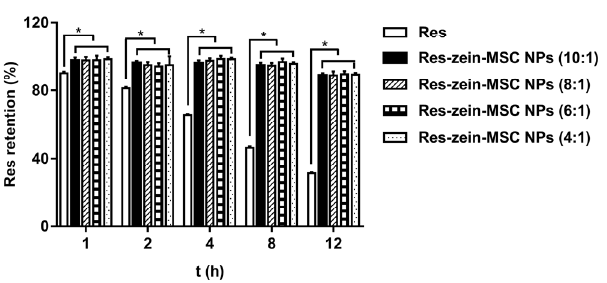
Figure 2. The photo-stability of Res and Res-zein-MSC NPs under UV radiation. Here, * represents a significant difference between samples ( p < 0.05).